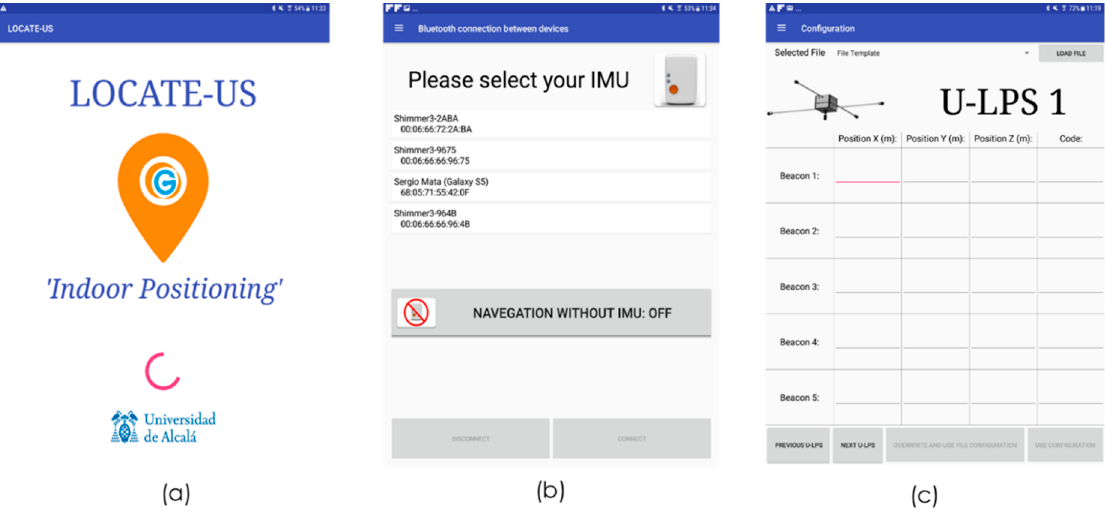
Figure 14. Screens from LOCATE-US application. ( a ) Welcoming screen, ( b ) Bluetooth IMU activation screen, ( c ) U-LPS configuration screen.